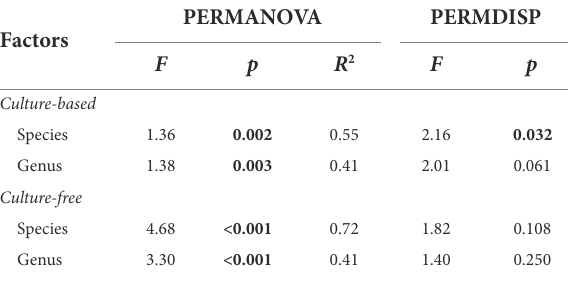
Supplementary Figure S5) in both the culture-free and culture- based surveys (Supplementary Table S8). LMA and leaf punch strength explained the most variation followed by %C and %N (Supplementary Table S8). Variance in endophyte community